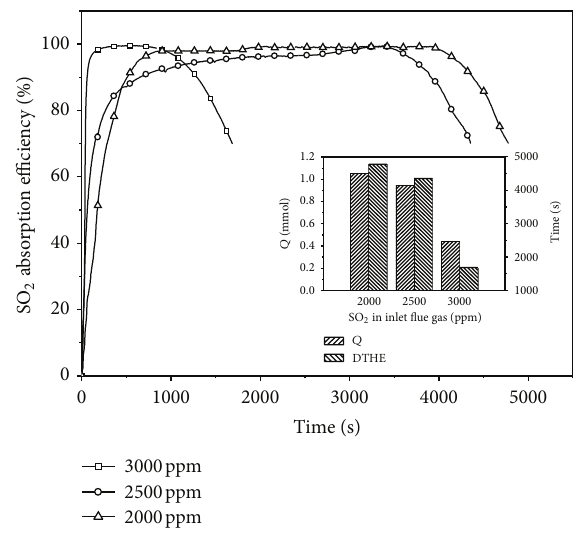
Figure 3: The effect of the inlet SO 2 concentration (gas flow, 0.12 m 3 /h; absorption solution, 100mL; O 2 , 5 vol%; 298K). The inset shows the absorption amount of SO 2 and